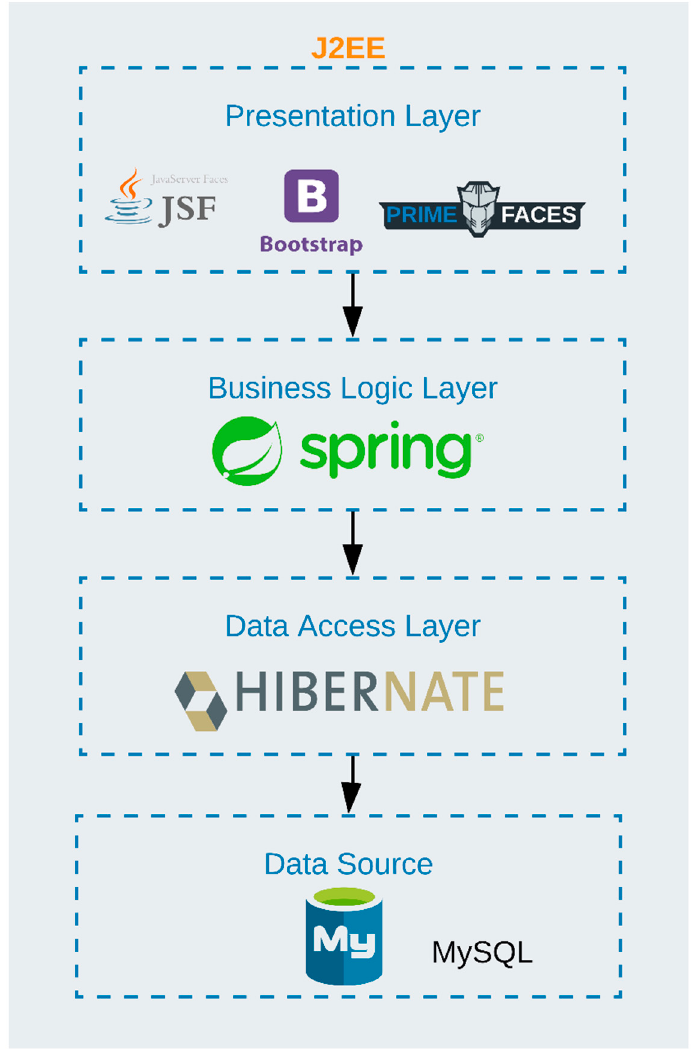
Figure 3. Layered architecture.